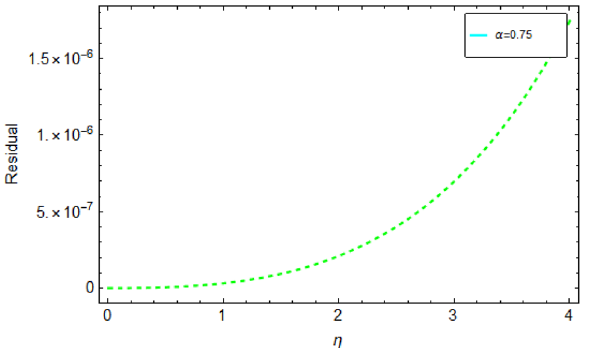
Figure 5. 2D surface shows the Residual obtain by the projected mode for FZK(3,3,3) for dissimilar values of α when τ = 0.1, y = 0.2 .